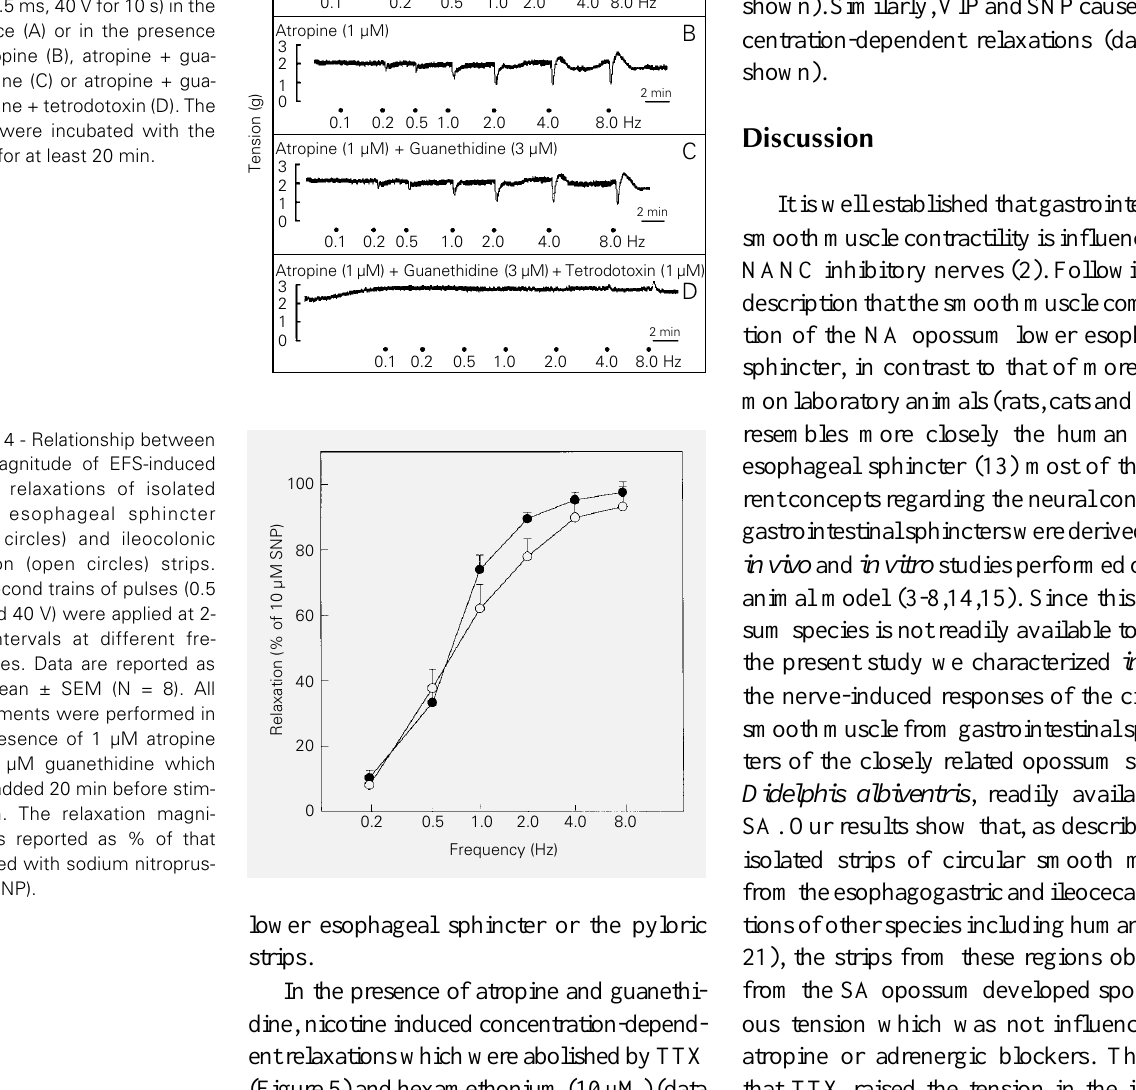
Figure 3 - Representative trac- ings showing the response of isolated ileocolonic junction strips to different EFS frequen- cies (0.5 ms, 40 V for 10 s) in the absence (A) or in the presence of atropine (B), atropine + gua- nethidine (C) or atropine + gua- nethidine + tetrodotoxin (D). The strips were incubated with the drugs for at least 20 min.